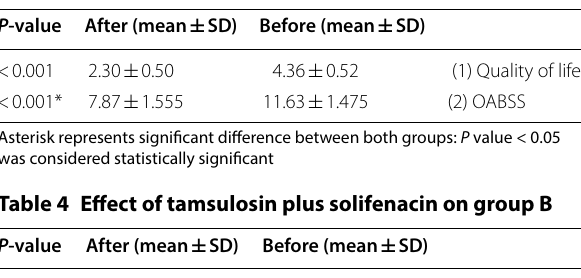
lost follow-up. The mean age of patients in this group Table 3 Effect of tamsulosin only on group A